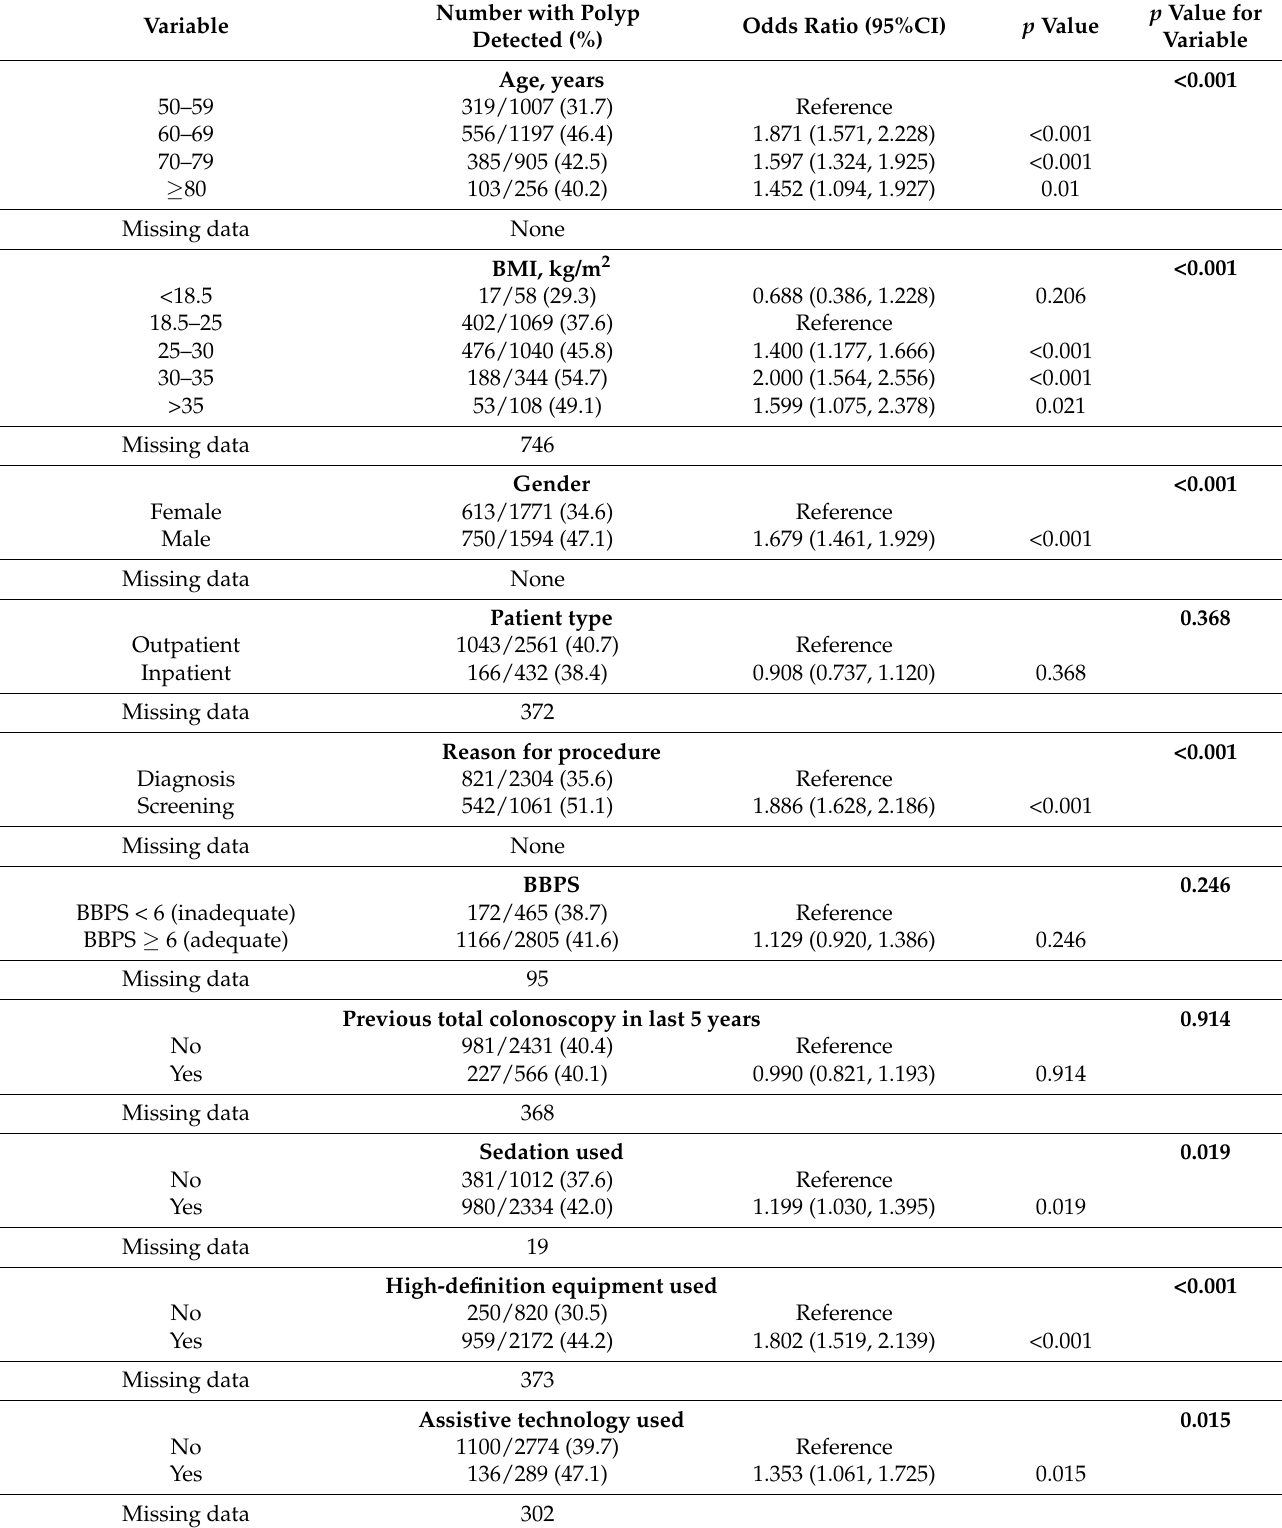
Table 1. Influence of individual variables on